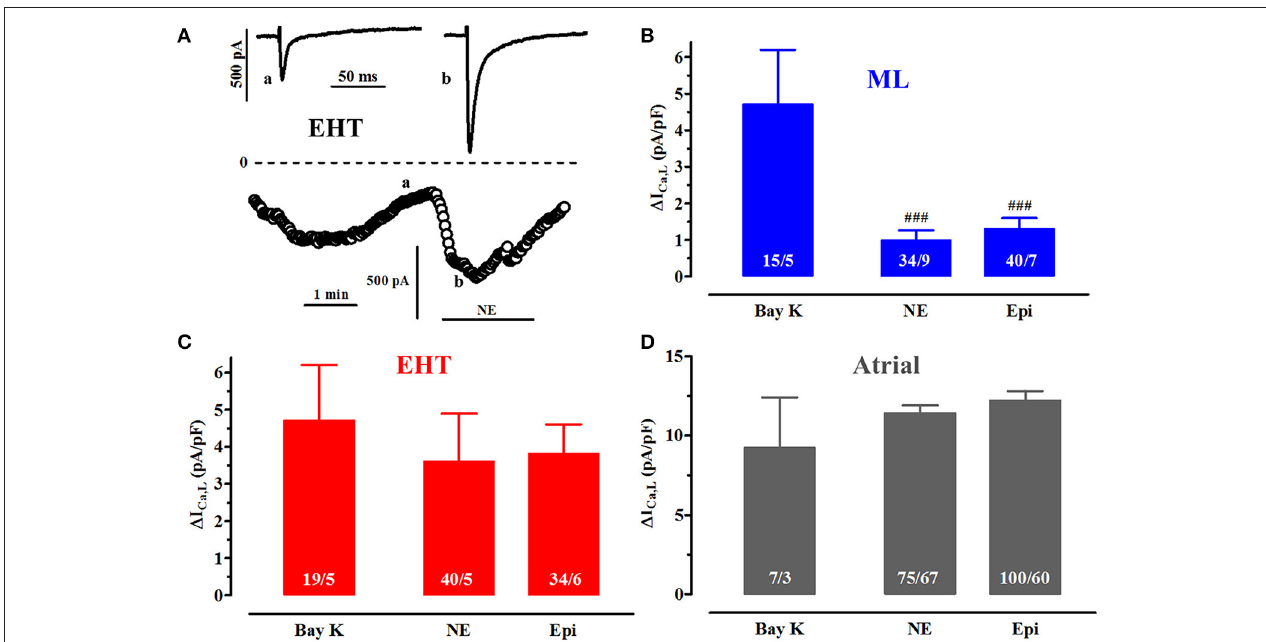
FIGURE 5 | Catecholamine effects vs. direct activation of ICa,L. (A) Time course of ICa,L upon exposure to norepinephrine (NE, 100 µ M) in a CM from EHT. Original tracings taken at time points indicated as a and b. (B–D) Mean delta values for the increase in ICa,L expressed as current densities upon stimulation of β 1-AR with NE (100 µ M), β 2-AR with epinephrine (Epi, 100 µ M) in the presence of the respective β -AR antagonist. Results from ML (B) , EHT (C) , and atrial CM (D) . Data for ( − )-Bay K 8644 were taken from Figure 4 and given as delta values for comparison. # indicates significance vs. ( − )-Bay K 8644. Please note different y axis scaling in D! N/N indicates number of cells vs. number of isolation for ML and EHT and number of cells/number patients for atrial CM.